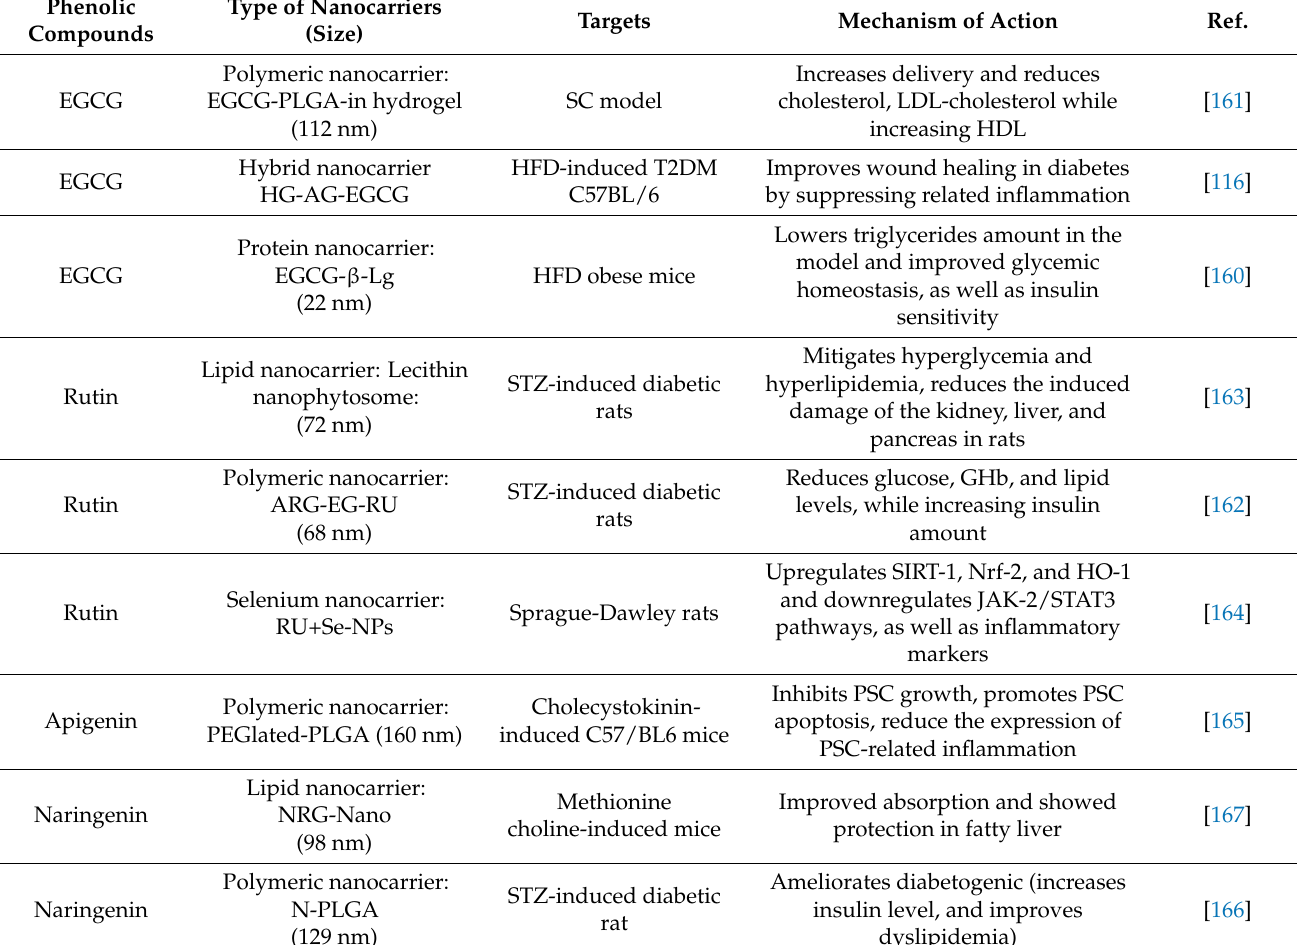
Table 3. Application of phenolic-loaded nanocarriers in metabolic